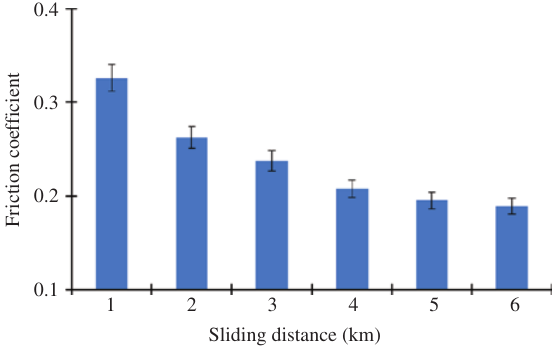
Figure 11: Friction coefficients of treated fine CNS filler composites (30%) with sliding distance.